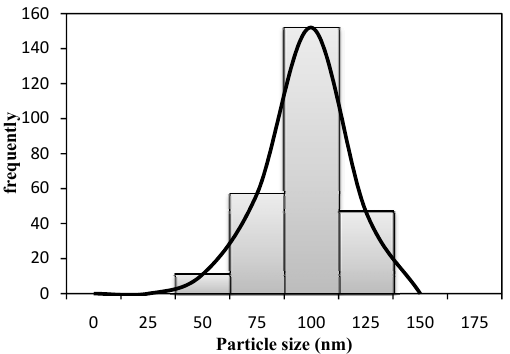
Fig. 4: Particles size distribution of nano LTA Fig.4. Particles size distribution of nano LTA zeolite.